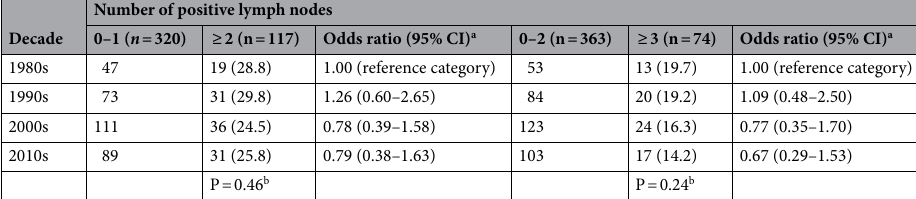
Table 4. Association of time period with the number of positive lymph nodes in patients with vulvar squamous cell carcinoma and > 10 lymph nodes dissected living in northern Italy (n = 437). a Simultaneously adjusted for patient age, tumour size, disease location and depth of stromal invasion. b Chi-square test for trend. CI, confidence